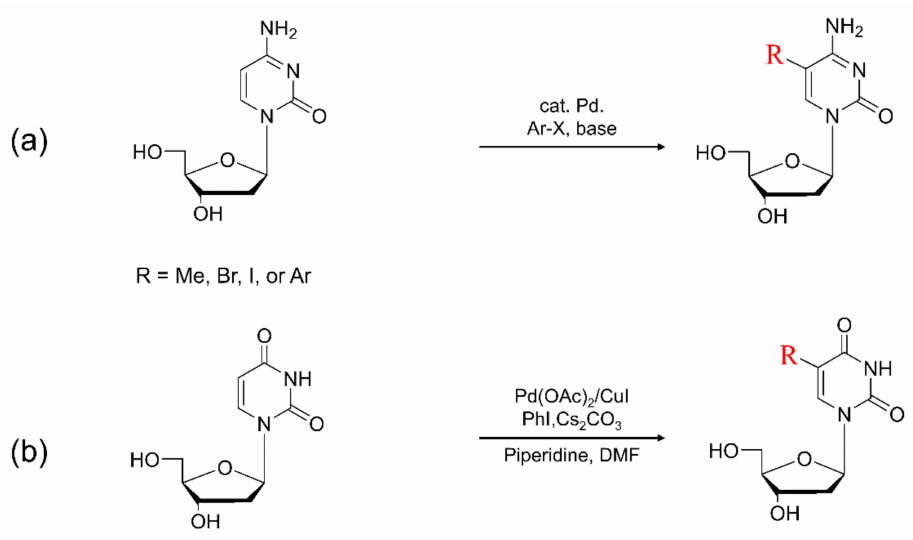
Figure 9. ( a ) Typical synthesis of 5-arylated cytosine. ( b ) Scheme for direct arylated uracil derivatives at the C5